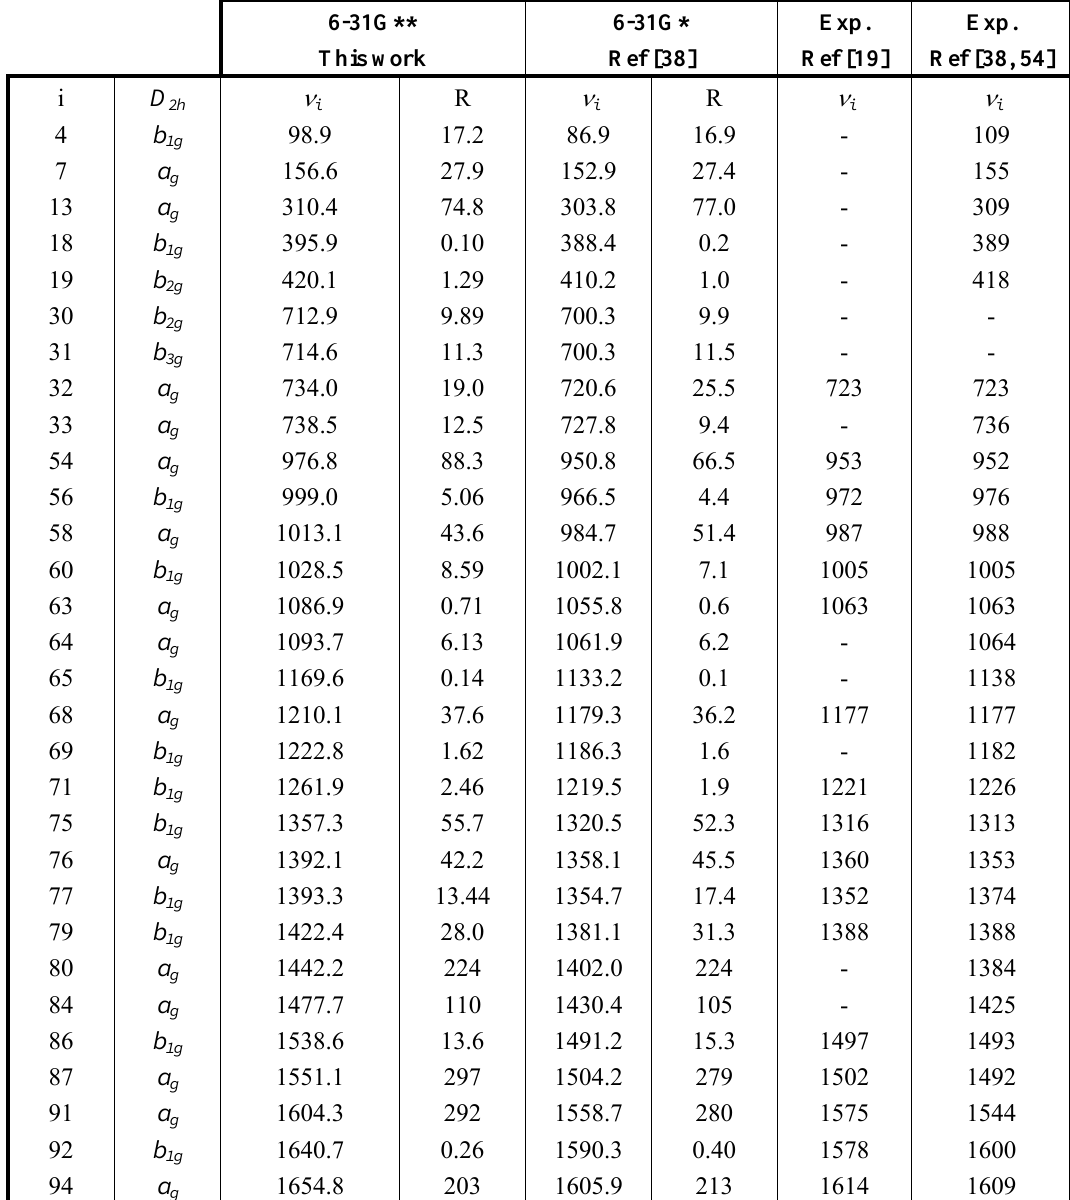
Table 5. The most important Raman fequencies of free-base porphyrin. “R” is the Raman scattering activity (Å 4 /amu), “  “ the wavenumber (cm -1 i